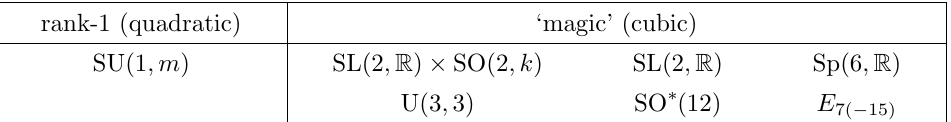
Table 2 . Isometry groups G of symmetric special K(cid:127)ahler manifolds [46]: e S (cid:17) G=K with K (cid:26) G a maximal compact subgroup. One has k = m (cid:0) 1 (cid:21) 1. The pre-potential F is quadratic and respectively cubic. ‘Magic’ SL(2 ; R ) has rank-1 as a symmetric space, but it has \rank-3" as a special geometry [32] as the rest of ‘magic’ special